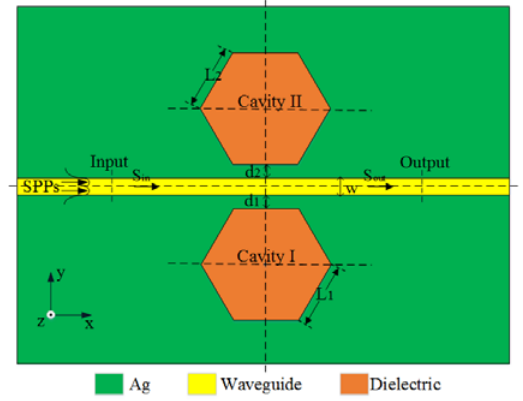
Figure 1. The Schematic of the plasmonic temperature ‐ sensing structure with dual laterally side ‐ coupled hexagonal cavities.